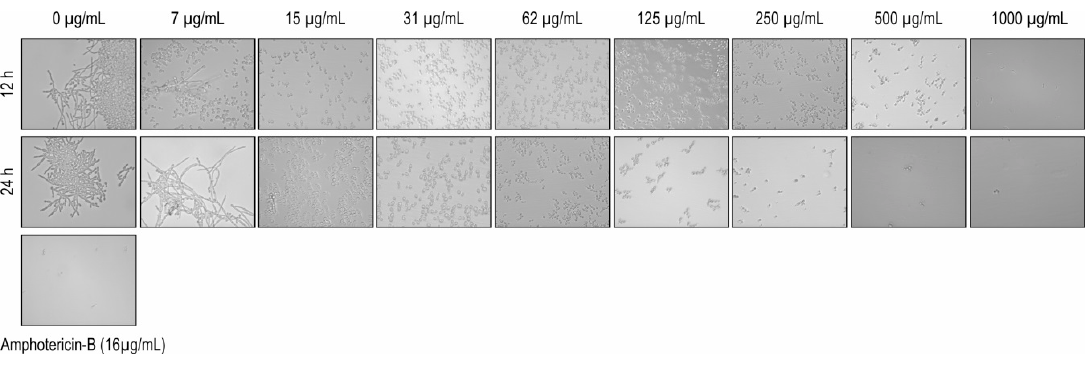
Figure 1. Inhibitory effect of essential oil of C. nardus on the transition of C. albicans from yeast to the hyphal form (photomicrographs by inverted light microscopic under 400× magnification).